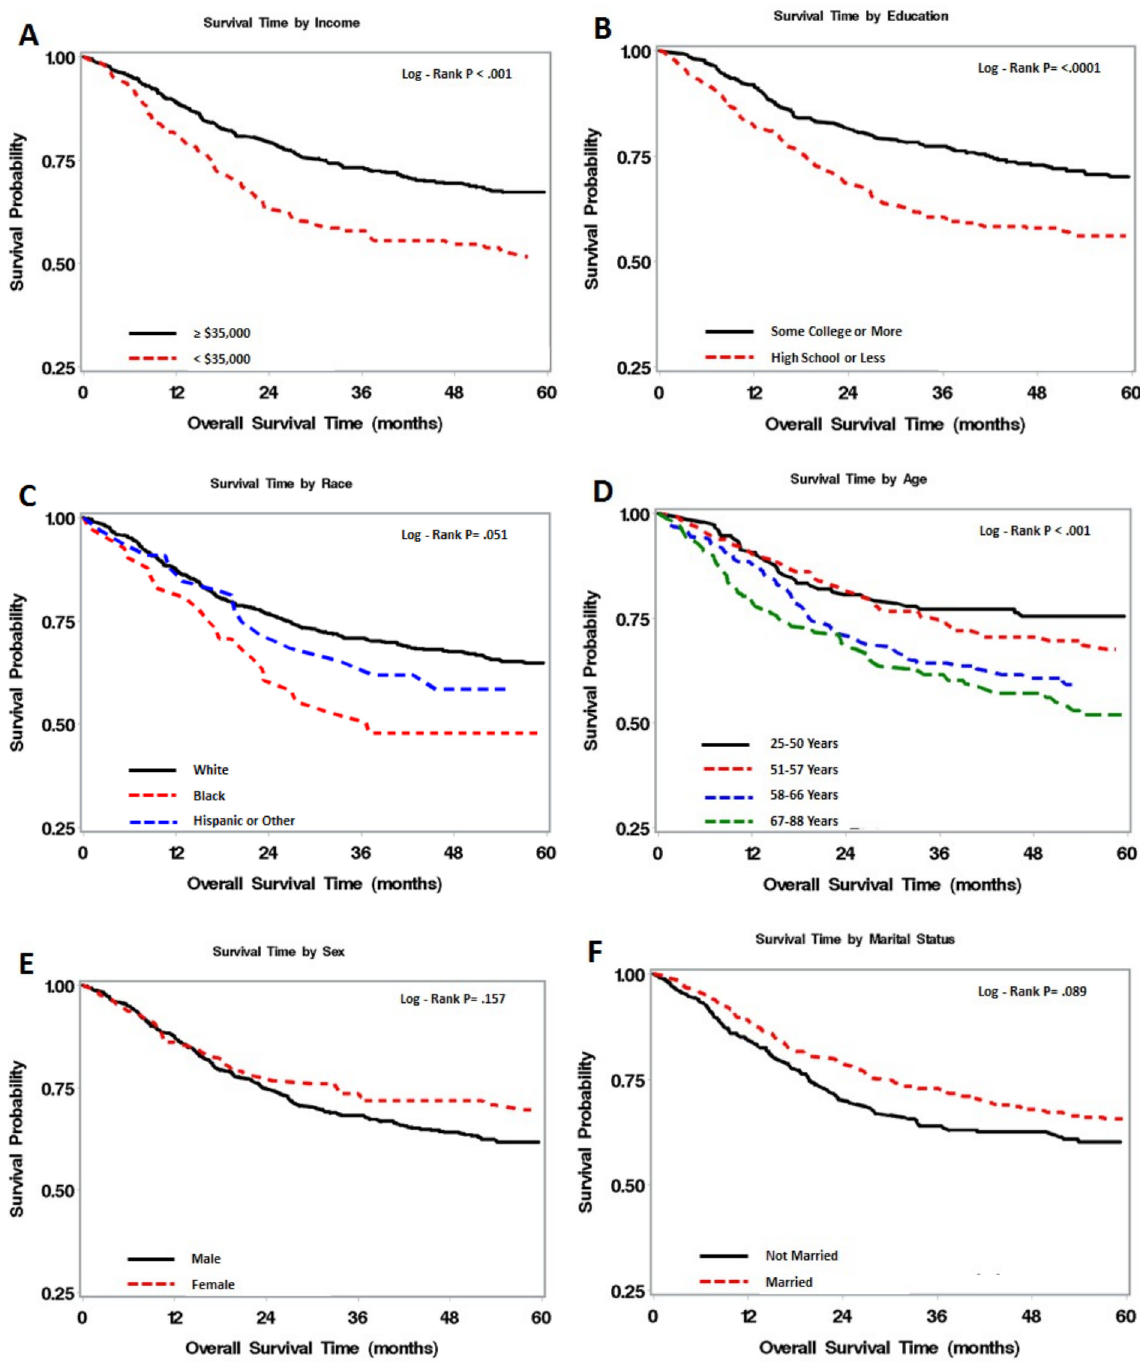
Fig 1. Kaplan-Meier survival curves for the independent